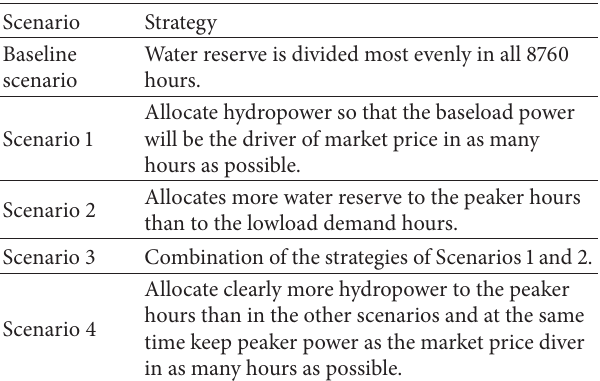
Table 2: Summarization of the strategies behind different hydropower